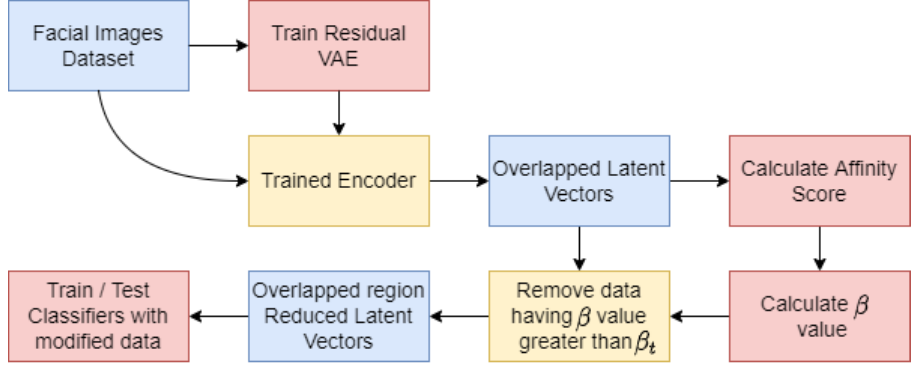
Figure 4. Proposed Residual Variational Autoencoder based Affinity score coupled overlapping region reduction method.